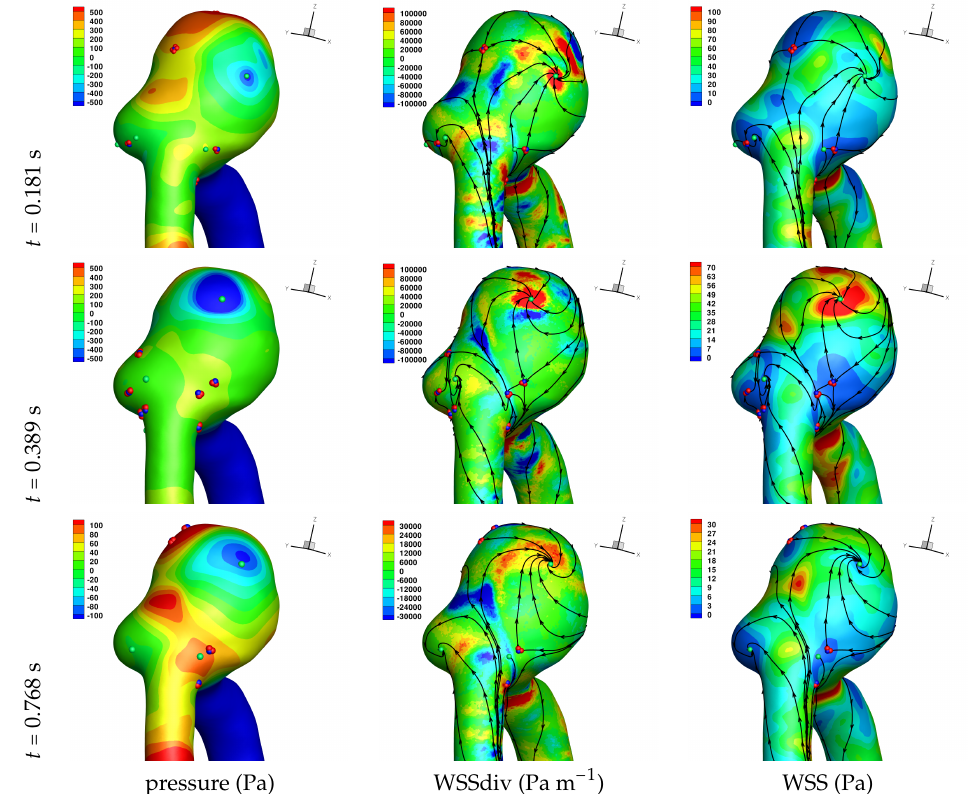
Figure 4. Solution for Case 1. Plots of surface shear lines and WSS critical points (colouring scheme as in Figure 3).